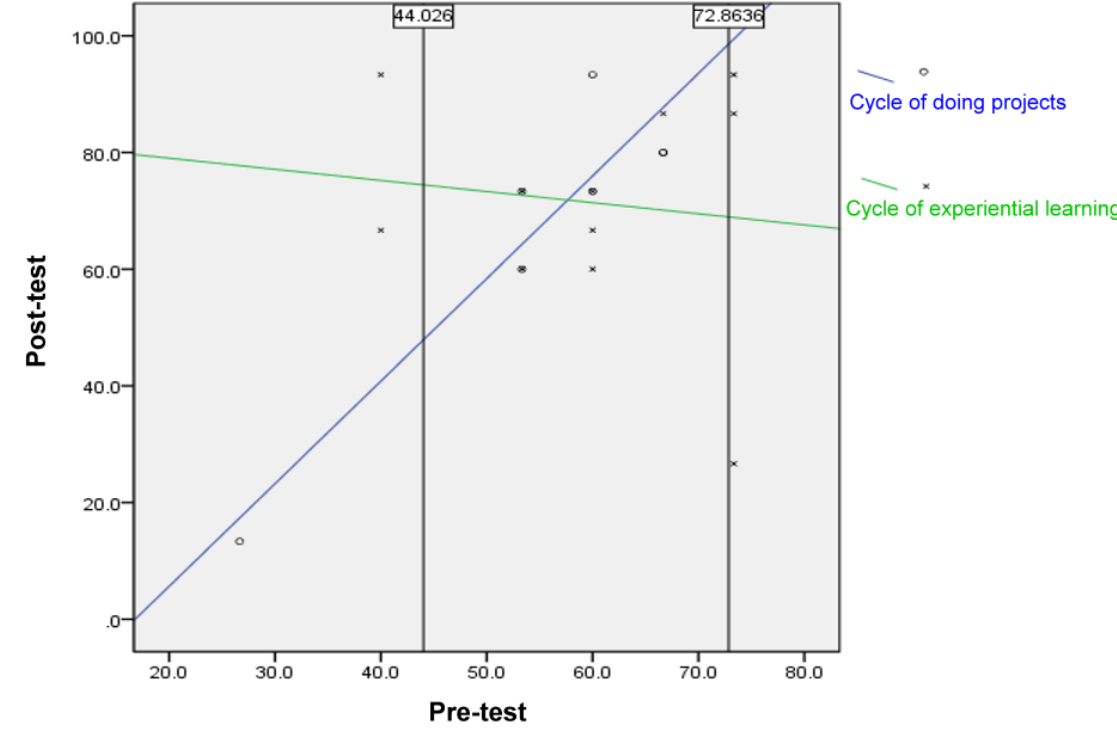
Results of Johnson-Neyman Process for Females Using Different Learning Approaches